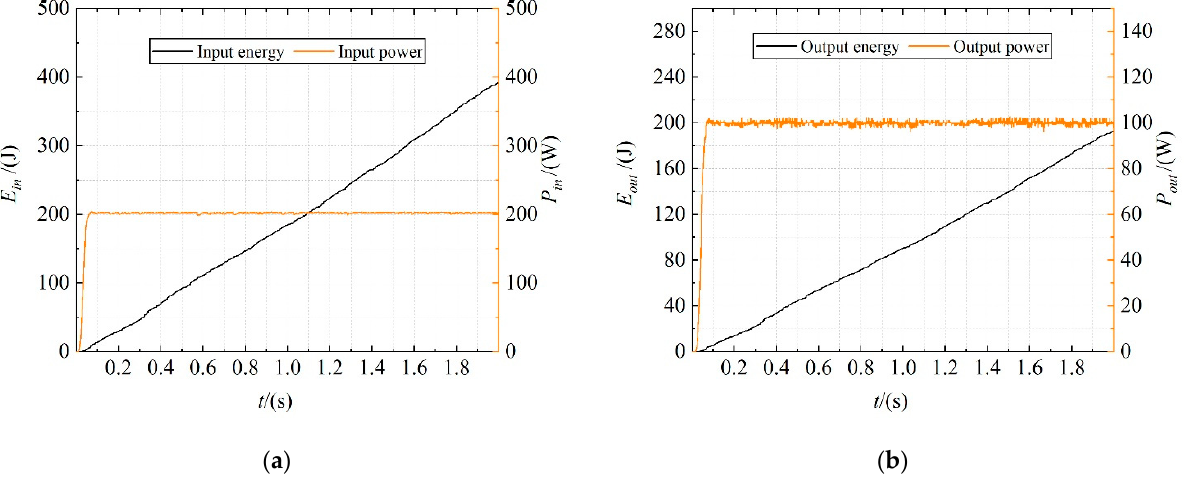
Figure 18. ( a ) The input energy and power of HTD; ( b ) the output energy and power of HTD.